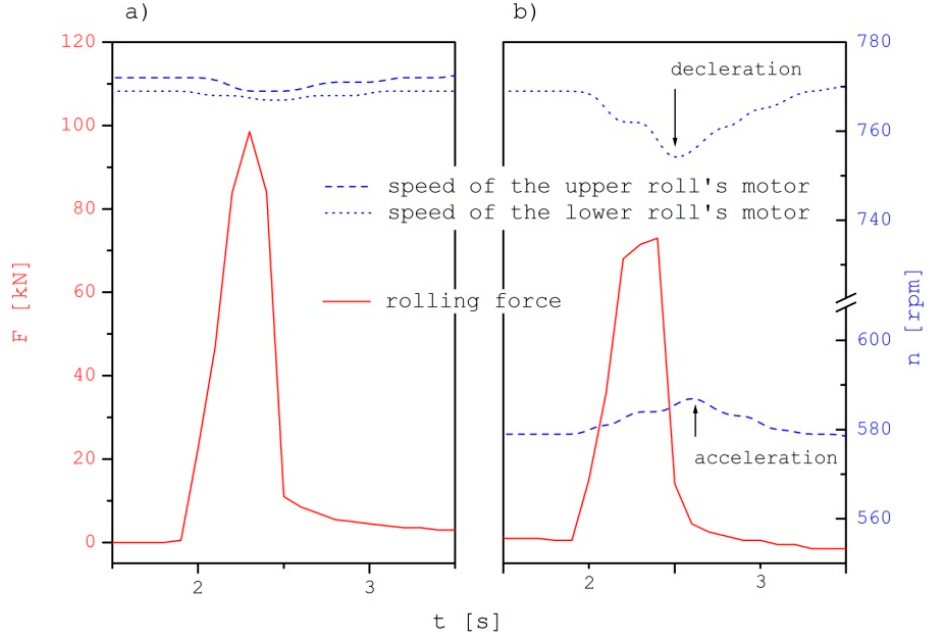
Figure 7. The course of changes in the value of the metal pressure force on the rollers and the rota- tional speed of the drive motors of the upper and lower rollers, ( a ) during symmetrical rolling, ( b ) optimal asymmetrical rolling. ( b ) optimal asymmetrical rolling.